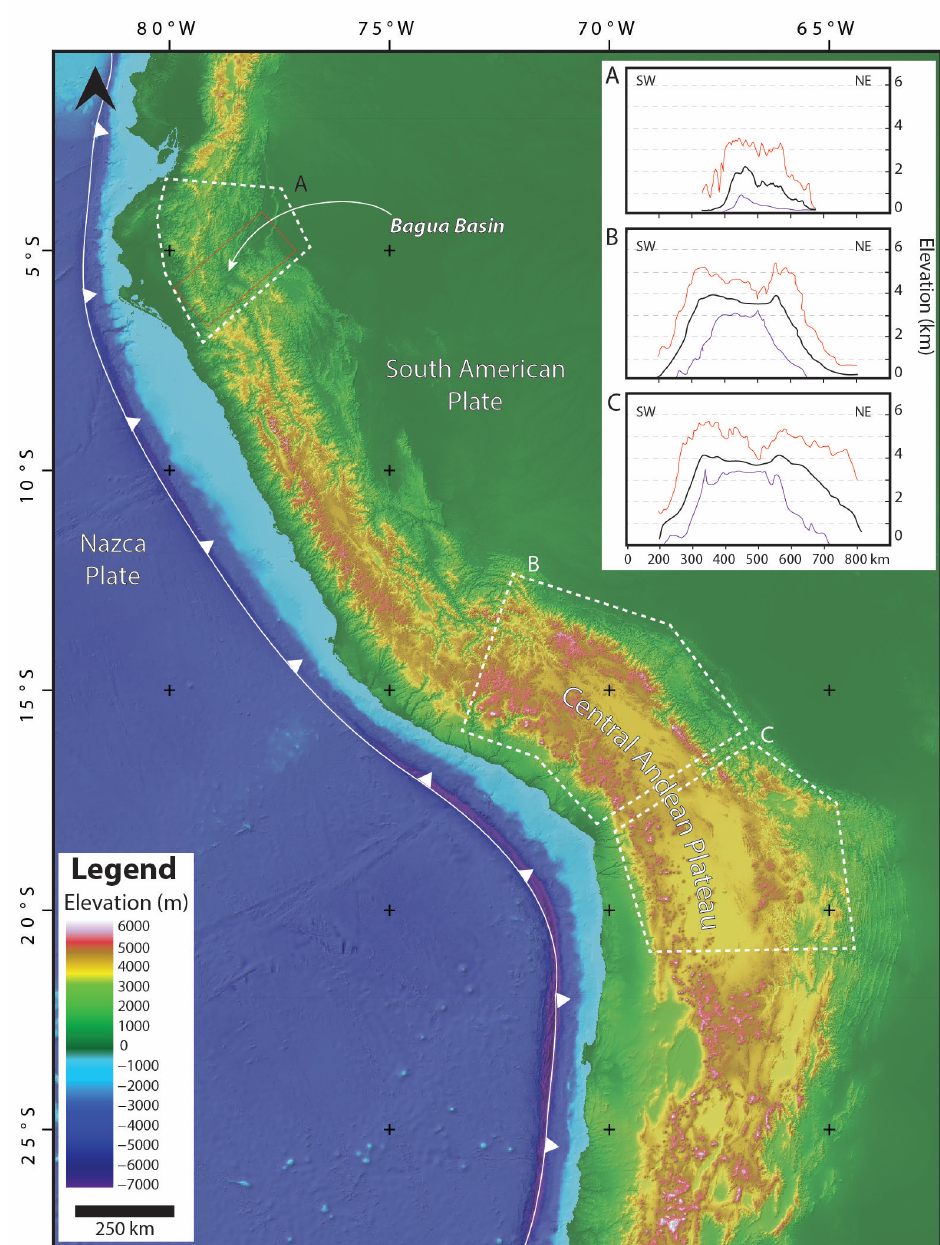
Figure 1. Digital elevation model of the Central Andes showing the location of the Bagua Basin and the Central Andean Plateau. Polygons and swath topographic profiles highlight the contrasting morphology of the ( A ) northernmost Central Andes and ( B , C ) the Central Andean Plateau domains. Black line in the swath topographic profiles shows the mean elevation, and orange and purple lines show maximum and minimum elevation, respectively. Swath topographic profiles were constructed using the online tool to produce swath topographic profiles along curved geomorphic features by Hergarten, et al. (2014) [38]. Red square shows the location of Figure 6A.